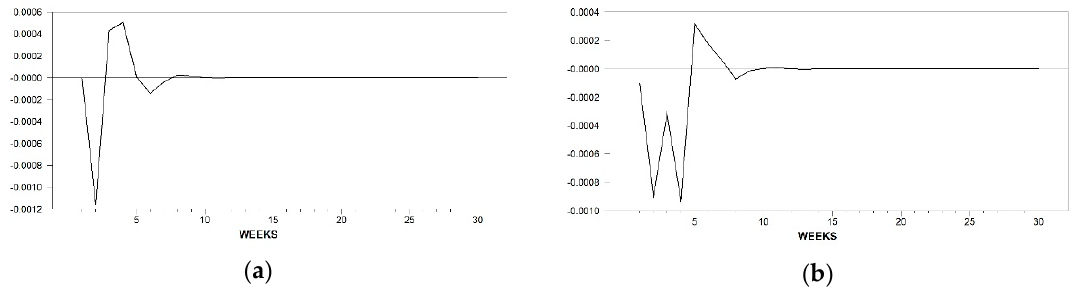
Figure 3. IRF for the generic Caciotta cheese. ( a ) Response of retail price to a shock in farm price; ( b ) Response of farm price to a shock in retail price. ( b ) Response of farm price to a shock in retail